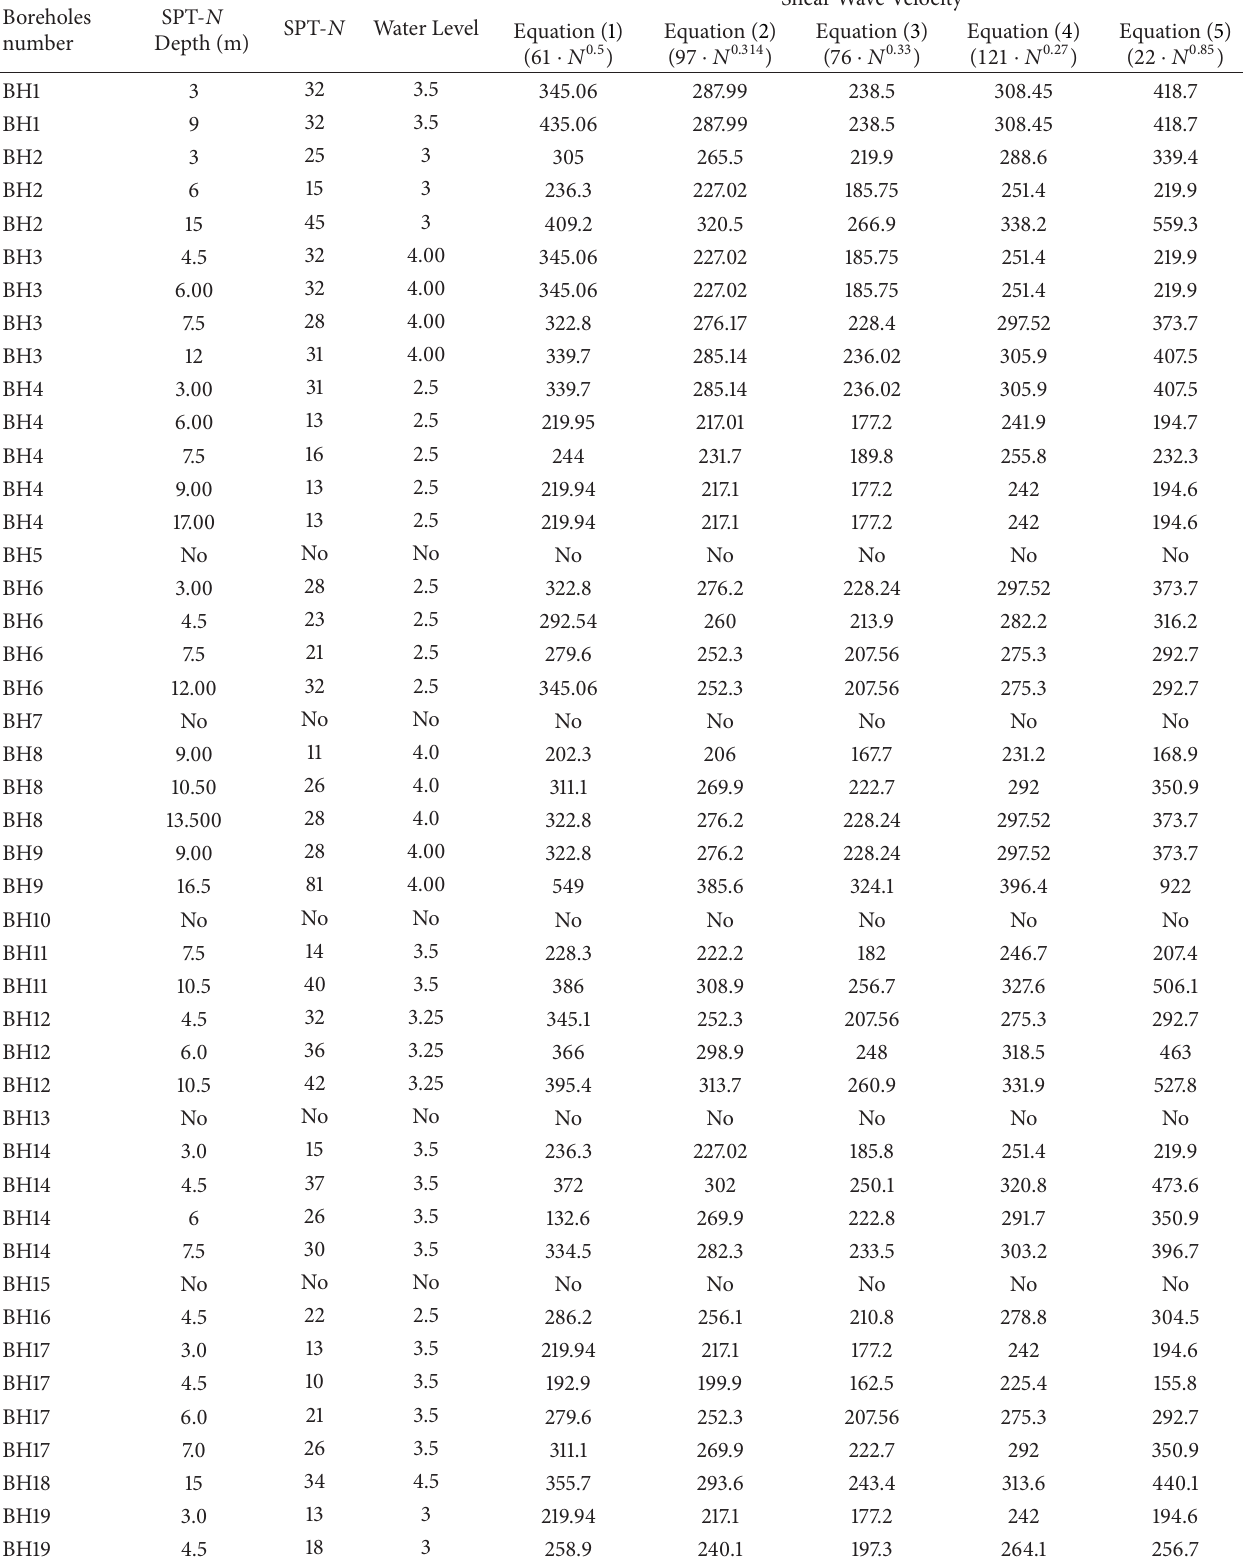
Table 2: Field data of Duzce